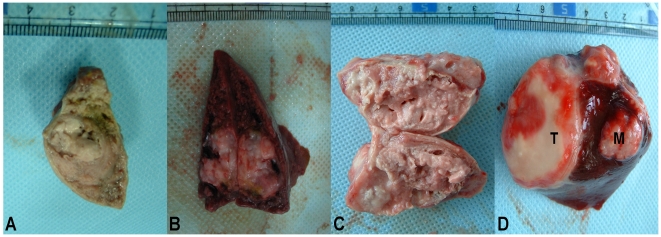
Gross pathologic specimens of response to different
treatment.Figure 6A and B Gross pathologic specimens of ATON-induced necrosis in
VX2 liver tumors treated with ATON embolization plus
hyperthermia (A) and with ATON embolization alone (B). C: Lipiodol
embolization resulted in significantly (P<0.05) larger tumors than
those of groups 1 or 2 at day 14. D: Gross pathologic specimens of a
tumor from an NS control rabbit (Group 4), showing a solitary mass (T)
and intrahepatic metastasis (M) at the time of death.